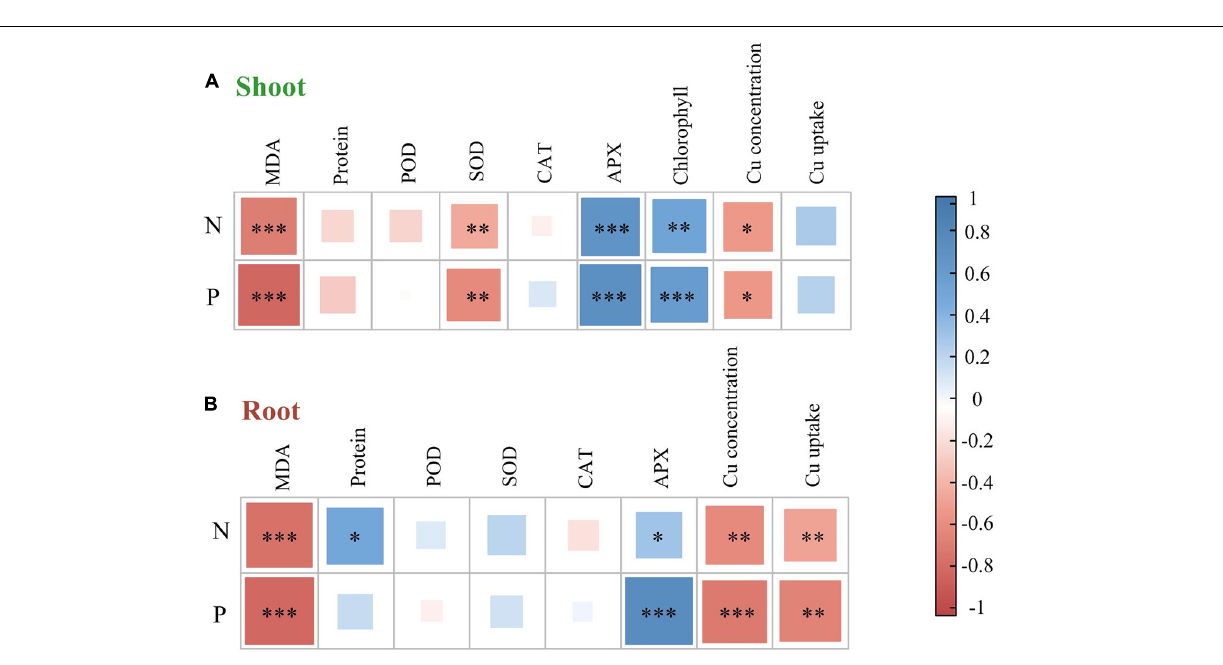
FIGURE 3 | A correlation heat map illustrating pairwise relationships between plant nutrient elements and plant properties in alfalfa shoot (A) and root (B) based on Pearson correlation coefficient analysis. N, nitrogen concentration; P, phosphorus concentration; MDA, malondialdehyde; Protein, soluble protein; SOD, superoxide dismutase; POD, guaiacol peroxidase; CAT, catalase; APX, ascorbate peroxidase. *** P < 0.001; ** P < 0.01; * P <